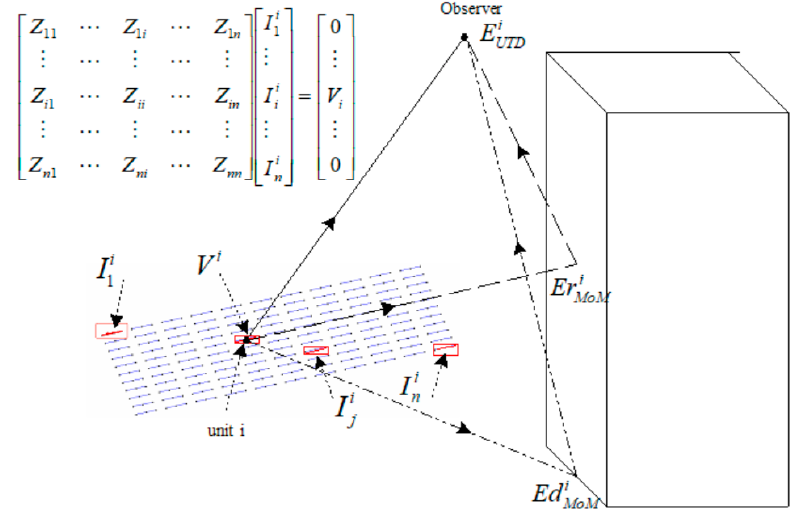
Figure 5. Illustration of calculation.